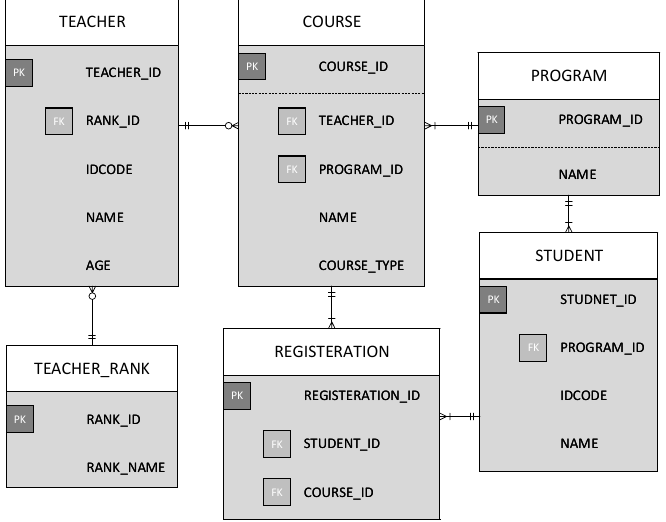
Figure 2. Database schema of Mini University